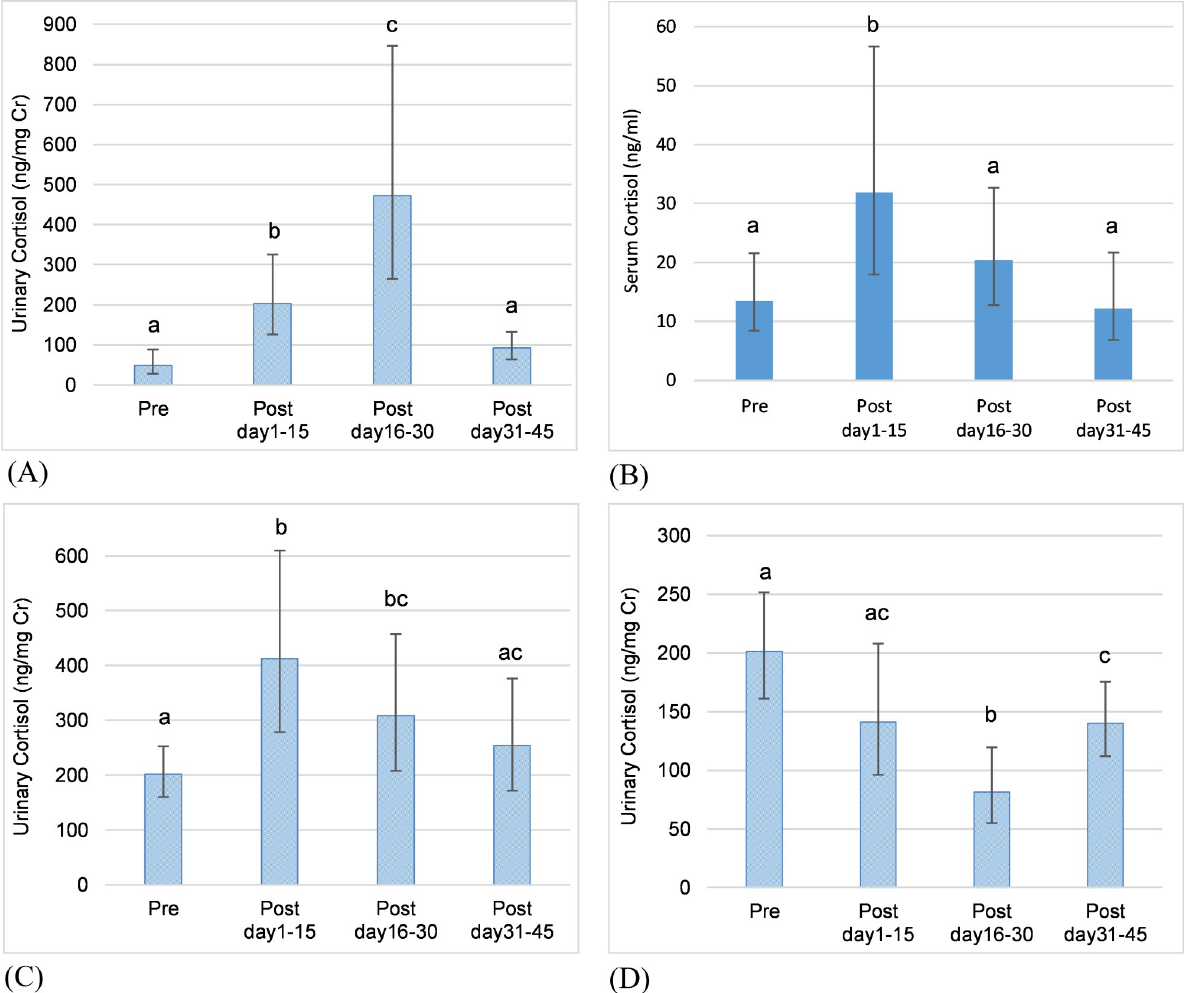
Fig 5. Facility transfer as a predictor of adrenal GC activity. Predictions from GLMMs for cortisol concentration comparing mean values in the 30 days prior to transfer and the 45 days post-transfer in 15-day time blocks (error bars represent standard error of the prediction). Letters denote significant differences in mean values across time periods. (A) Transfer 6 of herdmate, F9NZ response: Post > Pre in the first 15 days and increased again in the next 15 days; values returned to pre-event concentrations after 30 days. (B) F5NZ transfer of self: Post > Pre in the first 15 days after the transfer; values returned to pre-event concentrations after 15 days. (C) F8NZ transfer of self: Post > Pre in the first 30 days after transfer; values returned to pre-event concentrations after 30 days. (D) F9NZ transfer of self: No significant difference in the first 15 days, then Post < Pre for at least the next 30